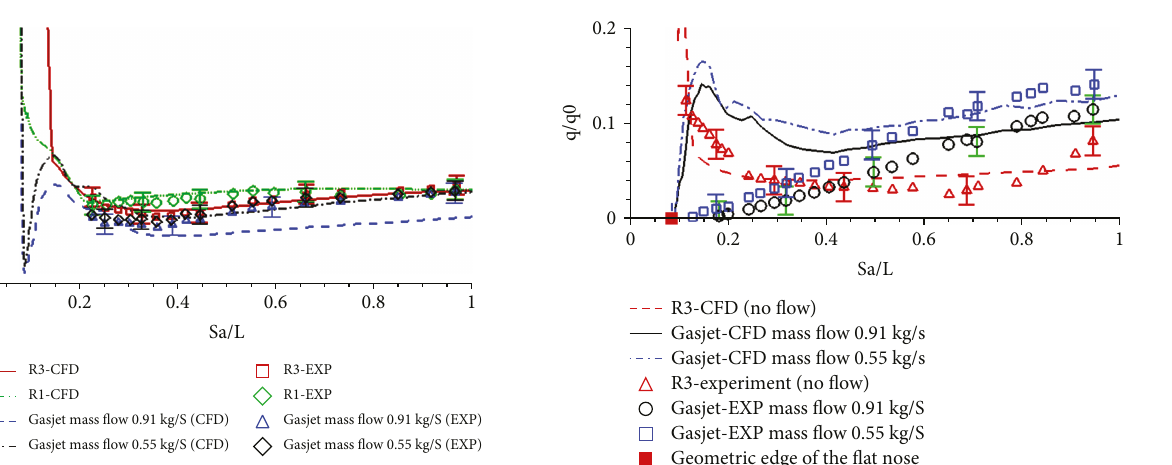
Figure 18: Pressure distribution on Gasjet and baseline models, Re = 4 3 × 10 6 , α = 0 0 ° , M = 6 8 .